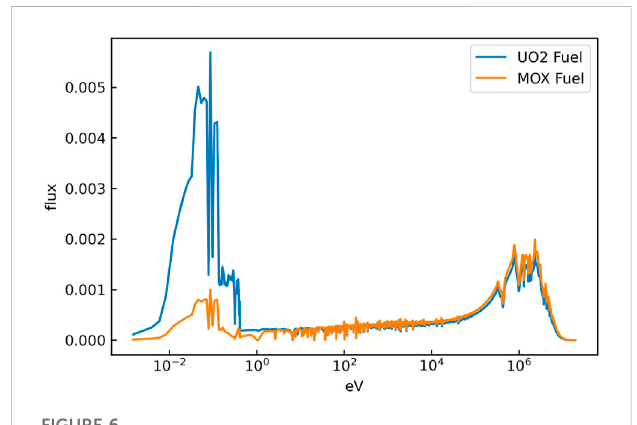
FIGURE 6 Flux comparison in fuel region.